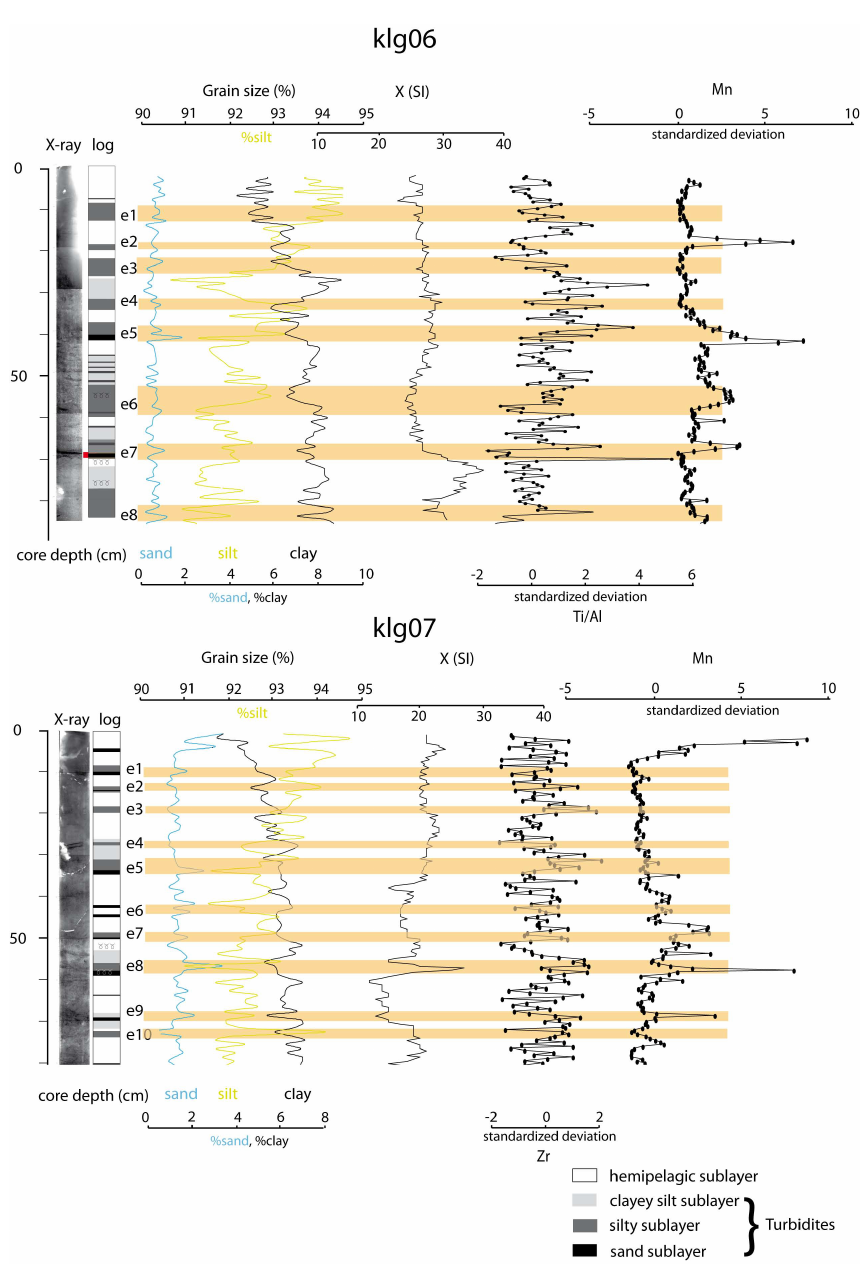
Fig. 6. Stratigraphic log for the first 80cm of the Klg06 and Klg07 cores situated in the Western High obtained by combining X-ray imagery, grain size, magnetic susceptibility data, Mn and Ti/Al or Zr standardized intensities. Main event deposits are identified and labelled; event labels change according to their stratigraphic position, beginning with 1 at the top of the core. The complete stratigraphic logs are presented in the Appendices (Figs. 12 and